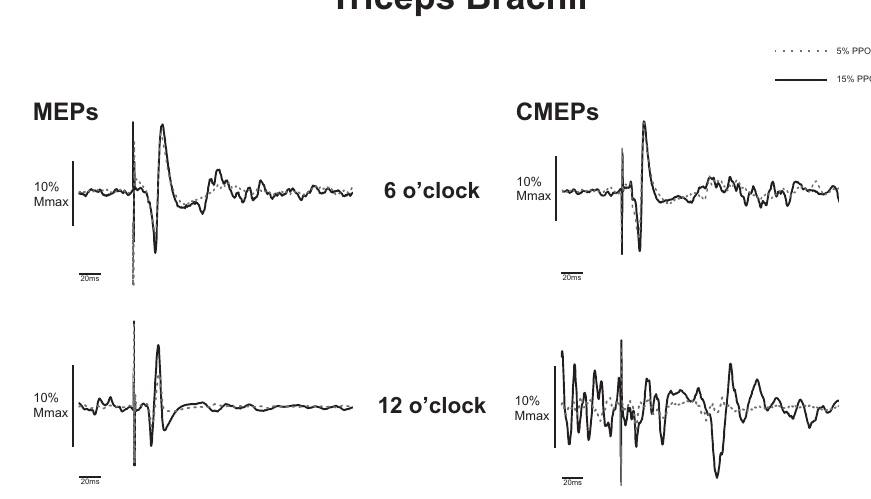
Figure 4. Triceps brachii representative example ( n = 1). Average motor evoked potentials (MEPs; left panel) and cervicomedullary evoked potentials (CMEPs; right panel) traces following eight stimulations during arm cycling at 5% PPO (dashed gray line), and 15% PPO (solid black line) at the 6 o’clock (top panel) and 12 o’clock (bottom panel) positions. Amplitudes are expressed as a percentage of maximal M-wave (M max ). Abbreviation is: PPO, peak power